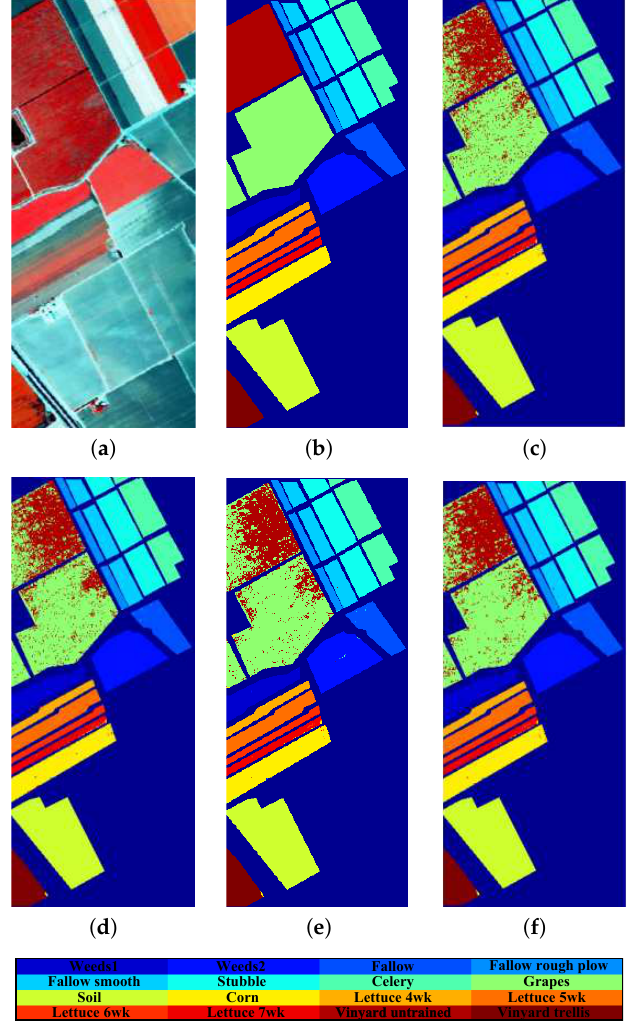
Figure 5. Thematic maps resulting from classification for the Salinas dataset with 16 classes. ( a ) pseudo-color image; ( b ) ground truth map; ( c ) LDA: 90.85%; ( d ) SLPP: 91.94%; ( e ) SGDA: 93.26%; ( f ) GDA-SS: 93.40